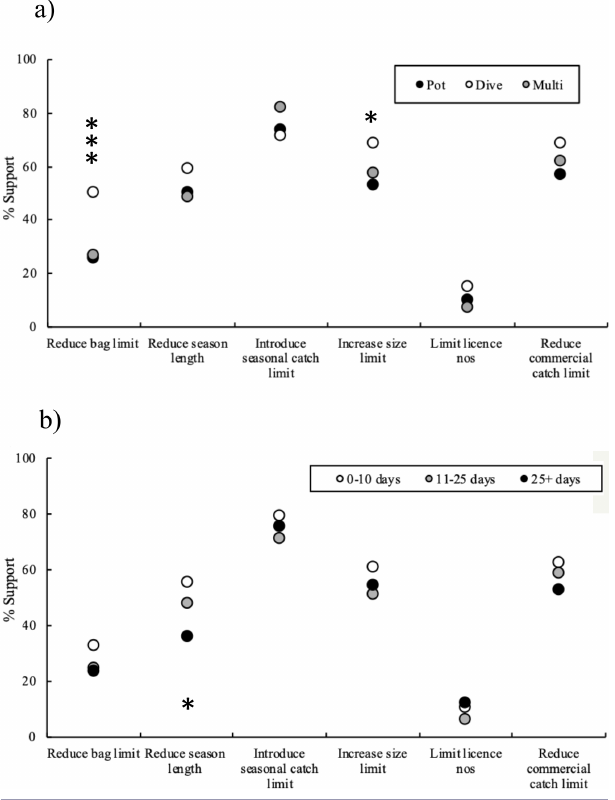
Fig. 4 . The proportion of fishers who support each management tool for (a) different fishing methods and (b) different levels of avidity determined by the number of fishing days per season. Unsure and NA responses were removed. Significant difference between groups from chi squared test of independence indicated by the asterisks, (p-values: <